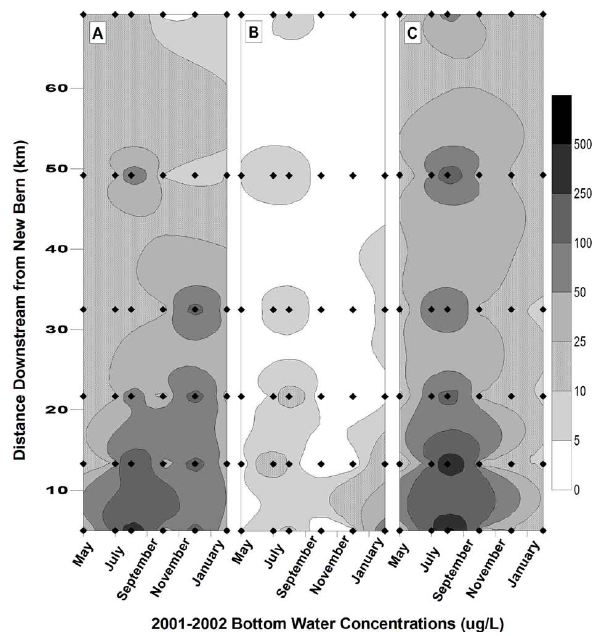
Figure 4 Fig. 4. Concentrations (ug N or P l − 1 ) of (A) NH + and (C) PO 3 − in bottom waters of the Neuse River estuary for May 4 2001 through early spring 2002. Contours are interpolated between sampling events (i.e., time) and